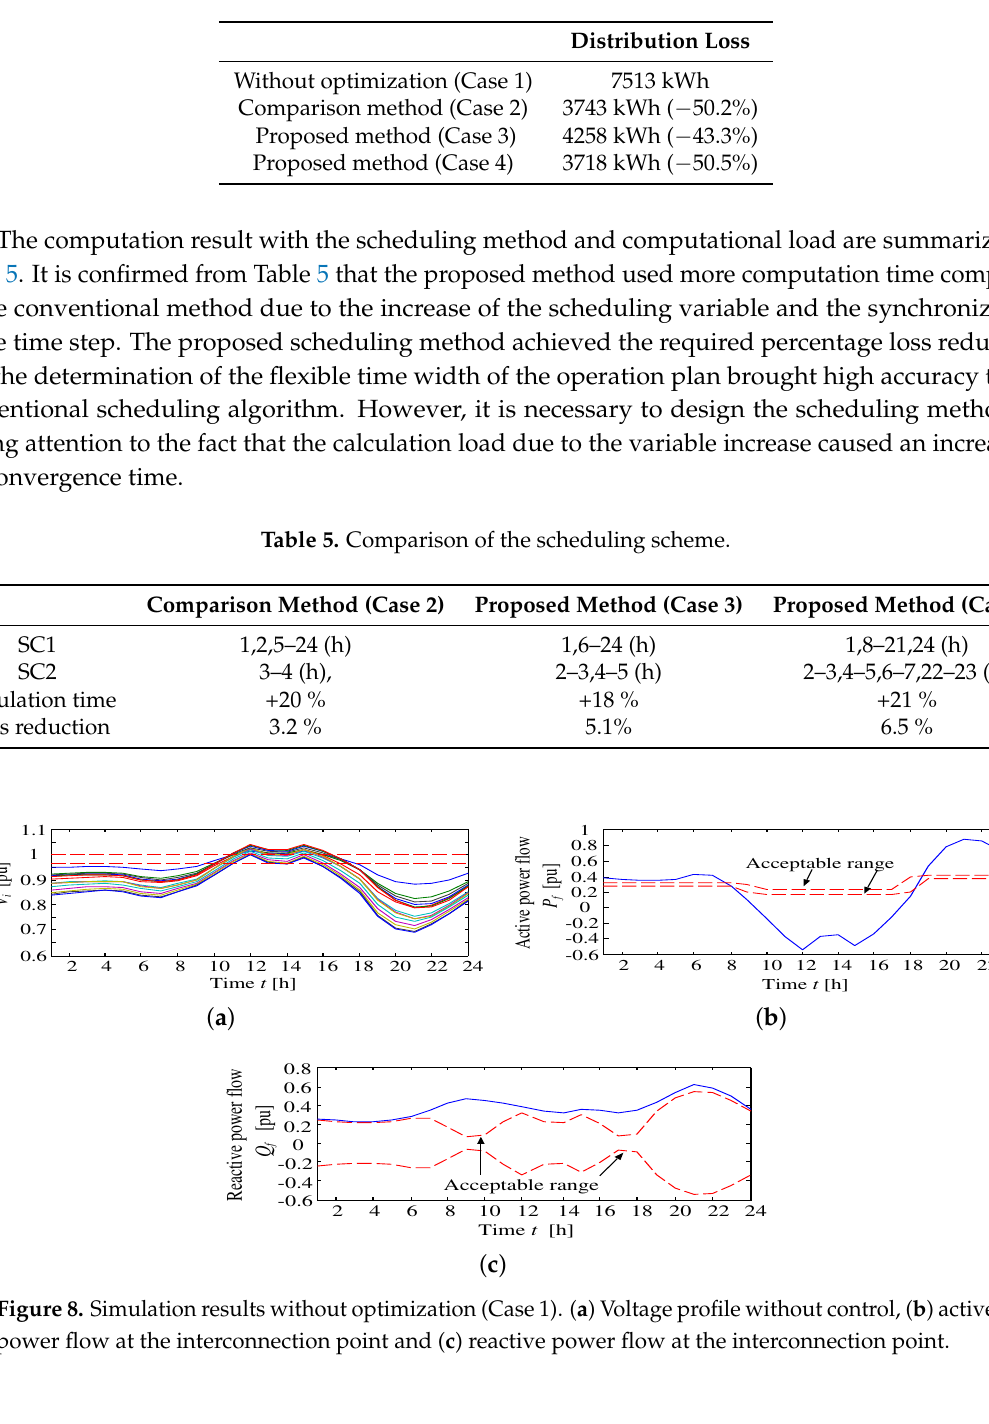
Table 4. Results of distribution losses for each case.